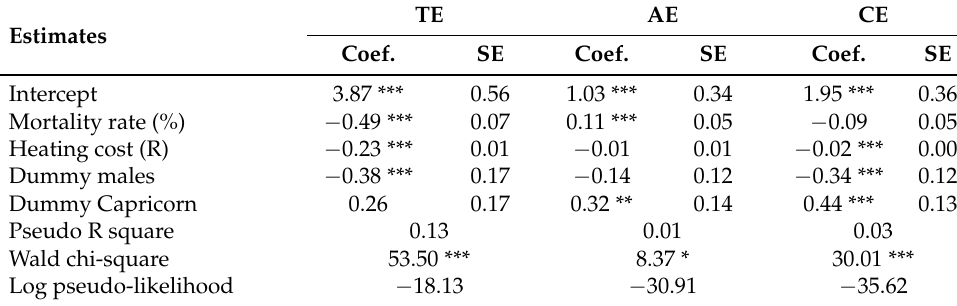
Table 3. Efficiency determinants from the fractional regression